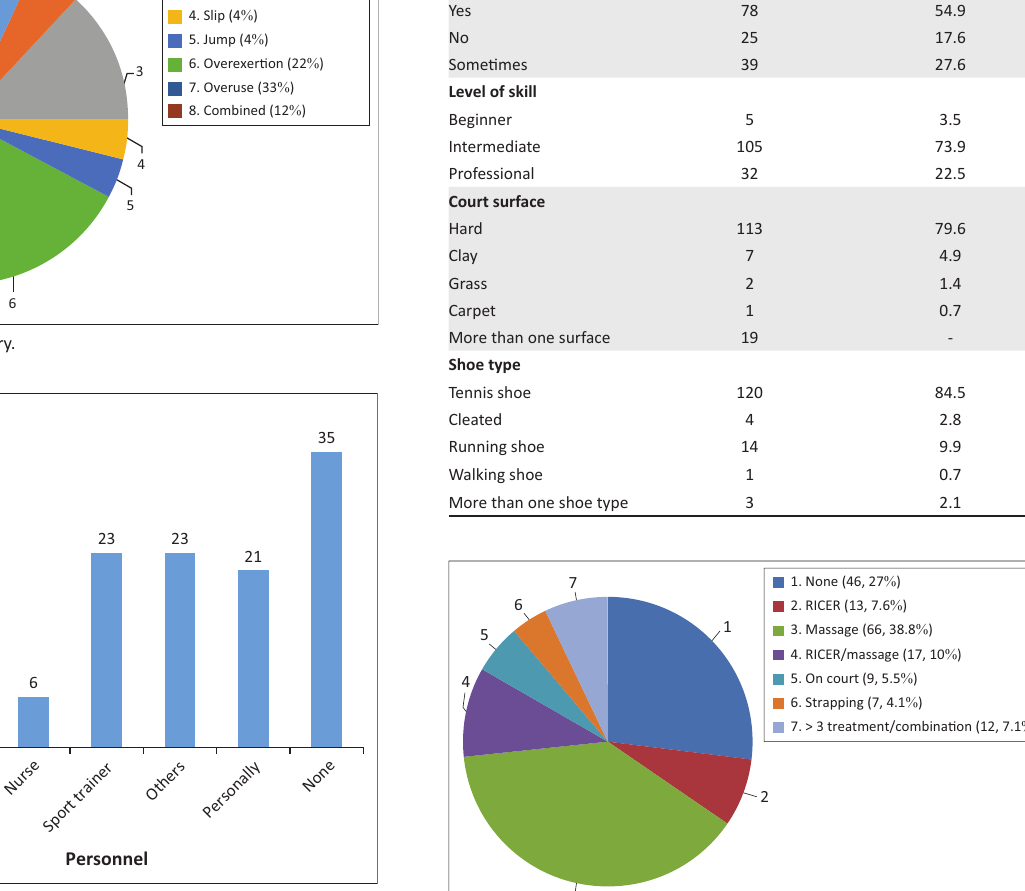
FIGURE 2: Personnel managing the available personnel and frequency of usage.